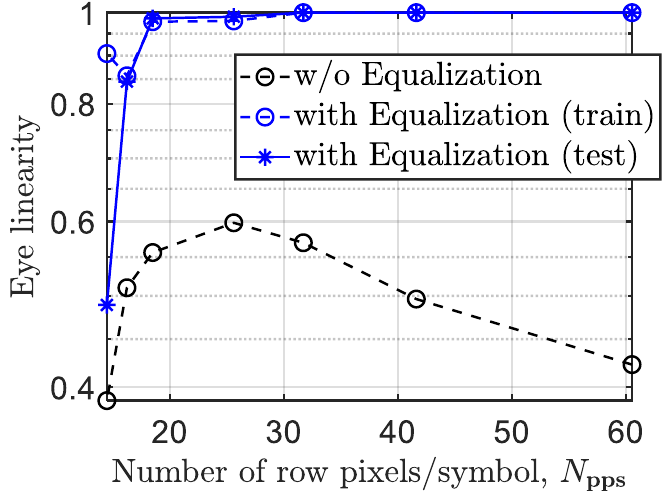
Figure 10. The eye linearity against 𝑁 pps for the proposed system with and without equalization and for T exp of 2 ms.